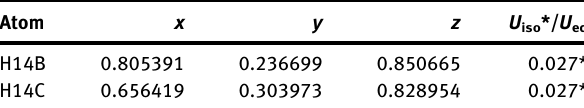
Table  : Fractional atomic coordinates and isotropic or equivalent isotropic displacement parameters (Å 